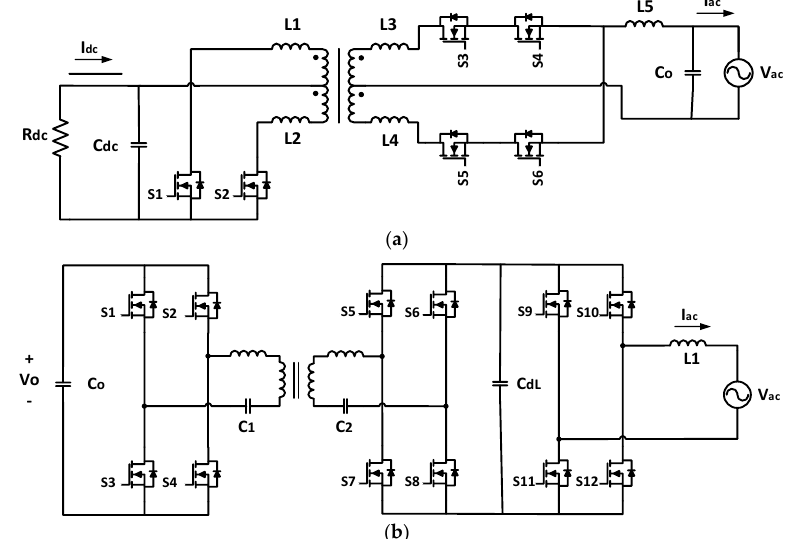
Figure 5. Illustration of bidirectional transformer topologies: ( a ) push-pull topology [63] and ( b ) isolated bidirectional boost rectifier AC – DC converter [51].